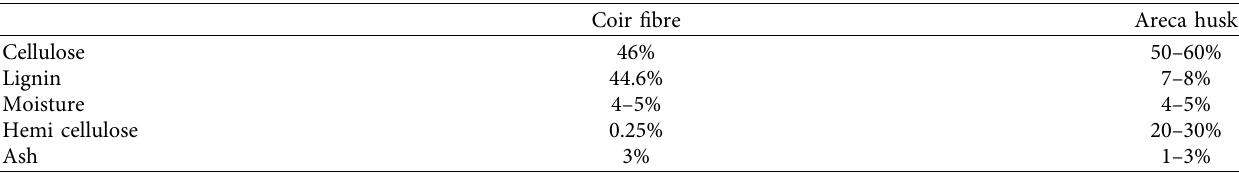
Figure 1: (a) Schematic images of sample collection channel. (b) Fixed bed for effluent treatment. Table 1: Characteristics of Coir fibre and Areca